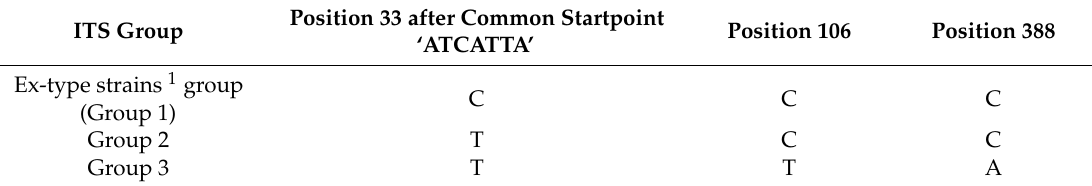
Table 1. Major variants in internal transcribed spacer (ITS) sequences among isolates identified as conspecific with the type of Acremonium